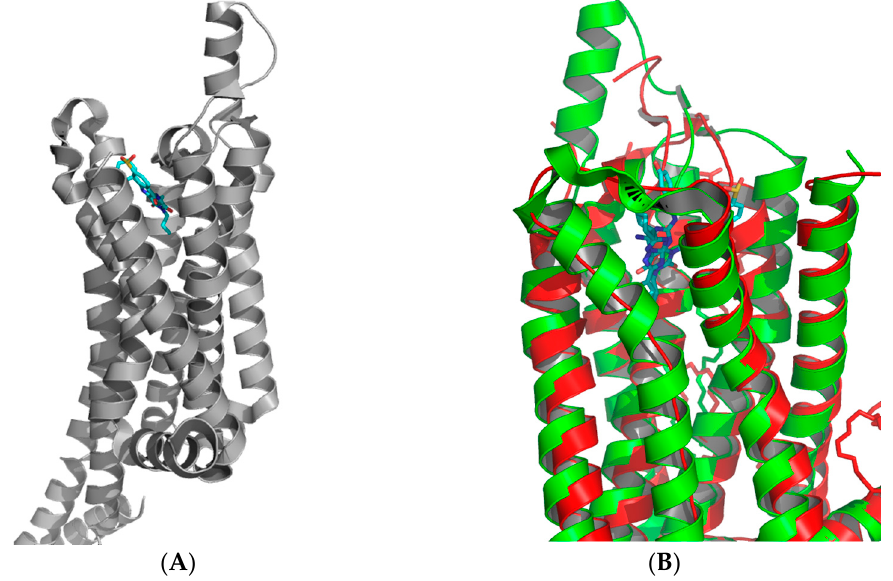
Figure 3. Structure of ( A ) adenosine A 1 receptor bound with the covalent antagonist DU172 (PDB: 5UEN); ( B ) overlay of the A 1 (green) and A 2A (red) receptors showing the significant difference in the extracellular loop region (ECL) between the two receptors [26,27].